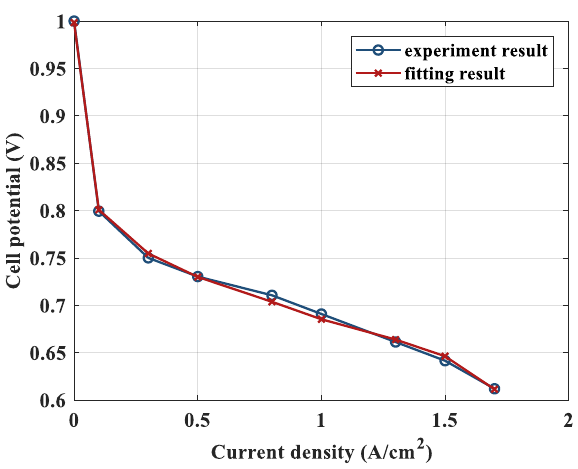
Figure 5. Fuel cell polarization curve calibration.